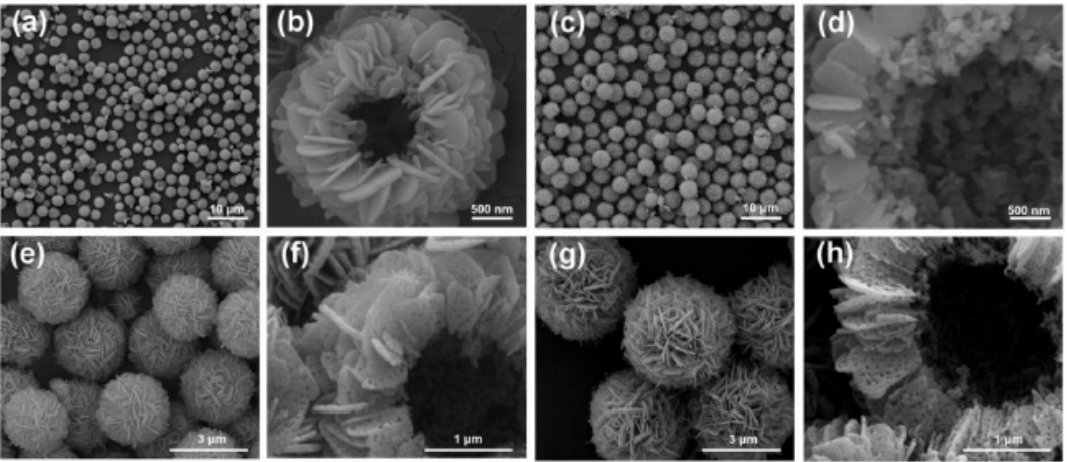
Figure 17. SEM images illustrating the strategy to hollow sphere assemblies of α -Co(OH) 2 nanosheets: ( a , b ) Precursor α -Co(OH) 2 -PVP-Low, ( c , d ) precursor α -Co(OH) 2 -PVP-High, ( e , f ) Co 3 O 4 -PVP-Low, and ( g , h ) Co 3 O 4 -PVP-High. Reproduced from [46], with permission from Elsevier, copyright 2018.